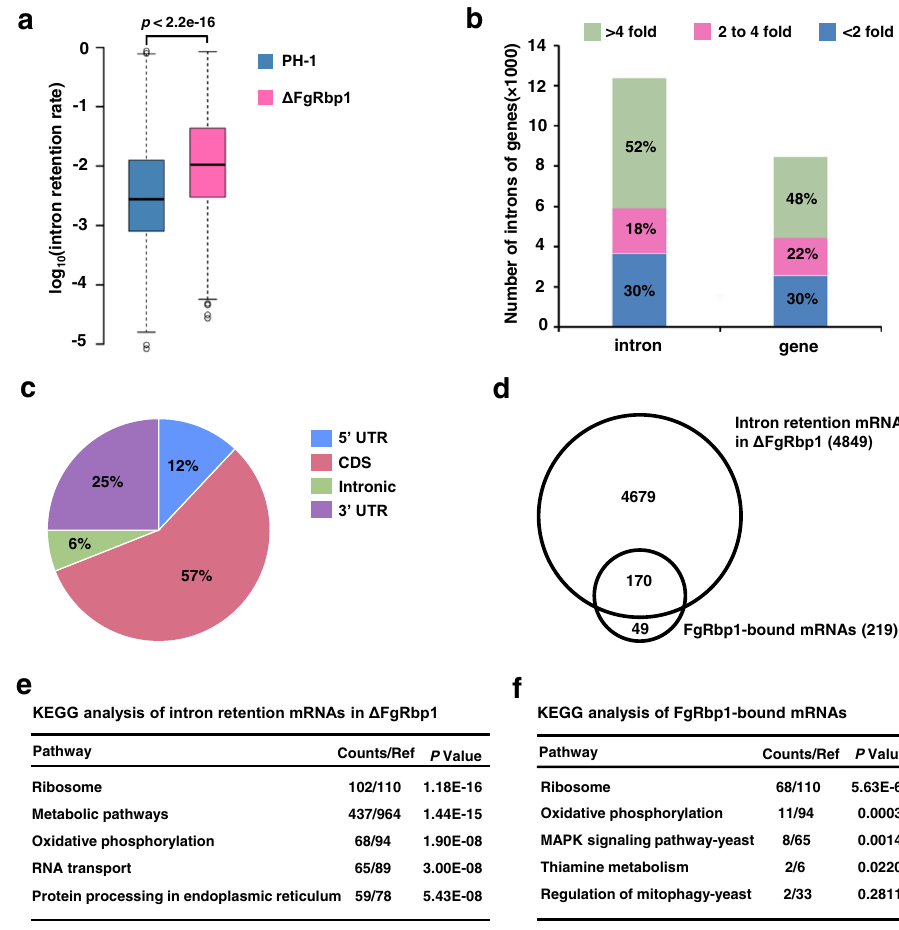
Fig. 3 Effects of FgRbp1 on pre-mRNA splicing and the identi fi cation of target RNAs of FgRbp1 by the RIP-seq assay. a Box plot of intron retention rates of PH-1 and Δ FgRbp1. Data are represented as boxplots where the middle line is the median, the lower and upper hinges correspond to the fi rst and third quartiles, the upper whisker extends from the hinge to the largest value no further than 1.5 × IQR from the hinge (where IQR is the interquartile range) and the lower whisker extends from the hinge to the smallest value at most 1.5 × IQR of the hinge, while data beyond the end of the whiskers are outlying points that are plotted individually. Statistical signi fi cance for the comparison was analyzed by two-tailed t test ( P < 2.2e-16). b The percentage of introns and genes with the three marked intron retention rates in Δ FgRbp1 compared with the wild-type PH-1. c Distribution of FgRbp1-bound peaks within protein- coding gene bodies divided into 5 ’ -untranslated regions (UTRs), coding sequences (CDSs), 3 ʹ -UTRs and intronic regions. d Venn diagram showing the overlap between intron retention mRNAs in Δ FgRbp1 and FgRbp1-bound mRNAs. e KEGG analysis of intron retention mRNAs in Δ FgRbp1. f KEGG analysis of FgRbp1-bound mRNAs identi fi ed in